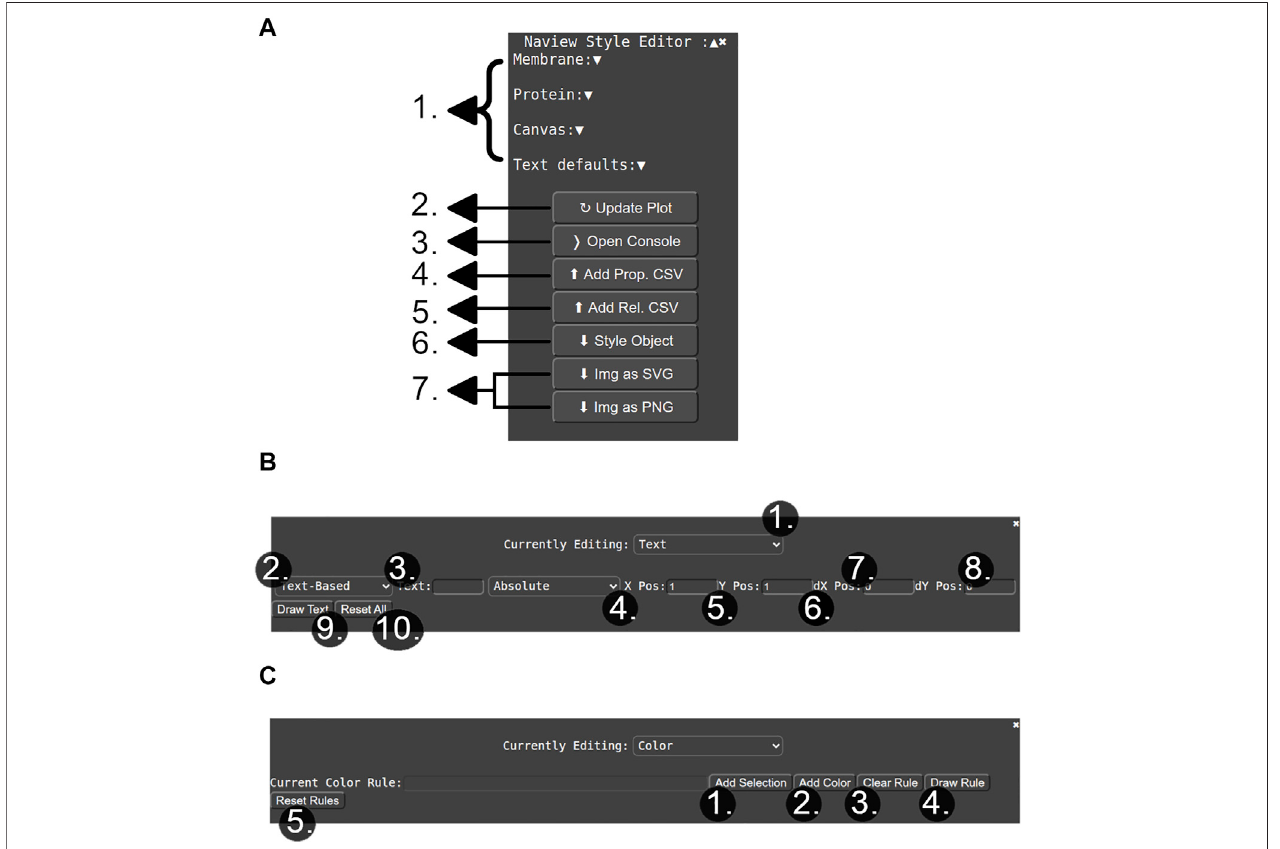
FIGURE2| Naview ’ sstyleeditor. (A) Main options ofthestyling menu including:1) Dropdowns foroptions related toeach ofthe drawndiagrams features such as colors, sizes and proportions. 2) Button for refreshing the currently drawn plot. 3) Button for opening the console that allows entering speci fi c text annotation or color rules.4)and5)arebuttonsforaddingpropertyandrelationshiprelateddatatotheplot.6)buttonforexportinga StyleObject withthecurrentlyselectedcon fi gurations.7) ButtonsforexportingtheplotimageintheSVGandPNGformats. (B) Consoleforaddingatextannotationorcolorrule.1)Dropdownforselectingbetweenthetext annotation or color rule modes. 2) Dropdown for selecting the input of free/property based text. 3) Input box for typing the desired text annotation. 4) Text positioning scheme: “ absolute ” de fi nes text position by the given “ x ” and “ y ” 5) and 6) parameters; “ relative ” de fi nes text position according to a selected element. “ dx ” and “ dy ” 7) and 8) shift the text to be drawn in the informed horizontal ( “ dx ” ) and vertical direction ( “ dy ” ), being especially helpful in the “ relative ” positioning scheme. 9) Button for appending the currently de fi ned text to the fi gure. 10) Removes all added text annotations. (C) Color rule addition console. 1) Opens a window for allowing speci fi c residue/elements selections. 2) Opens a window for selecting a speci fi c color/property-based color mapping. 3) Clears the currently selected color rule. 4) Updates plot with the currently selected color rule. 5) Removes all previously added color